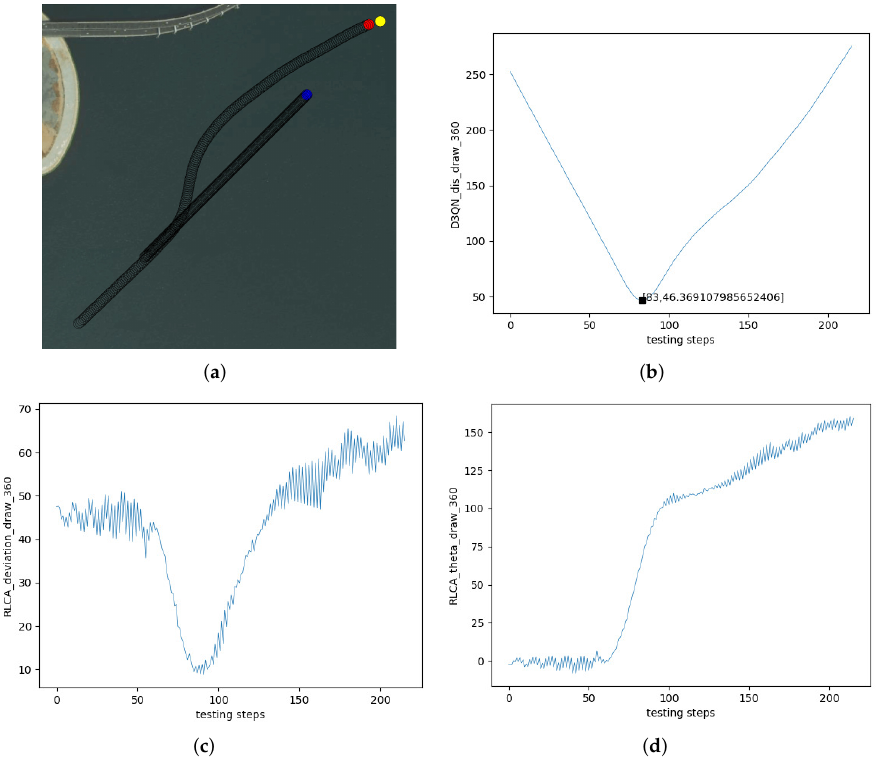
Figure 20. Test effect of the overtaking encounter. ( a ) Overtaking. ( b ) The distance between two USVs. ( c ) The course of the own USV. ( d ) θ of the own USV.